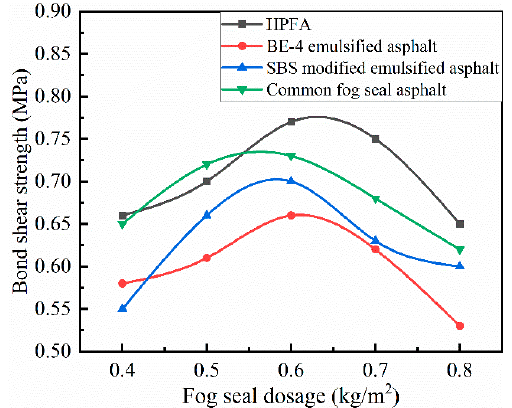
Figure 17. Bond performance of different amounts of fog seal.